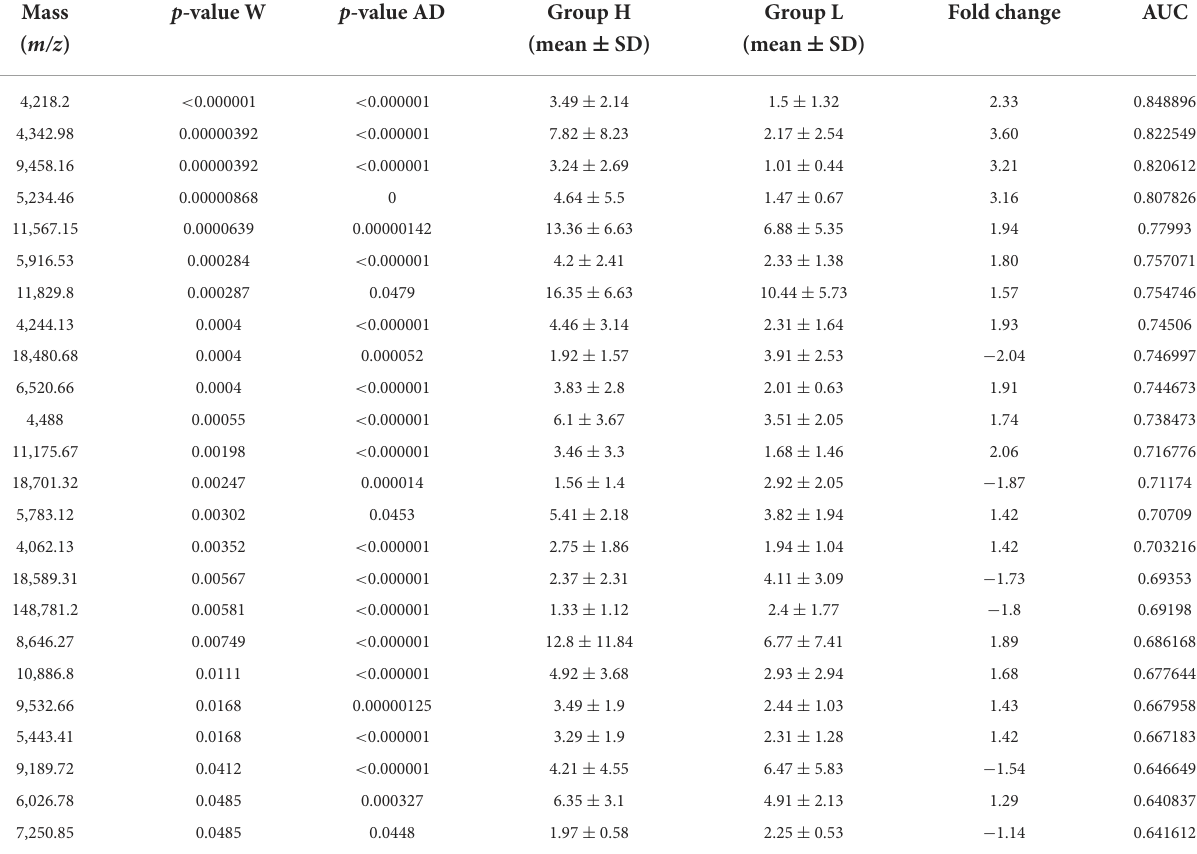
TABLE 2 Mass signals and corresponding intensity values (mean ± SD) of peaks significantly different between group H (SCC > 200,000 cells/ml) and L (SCC < 200,000 cells/ml).